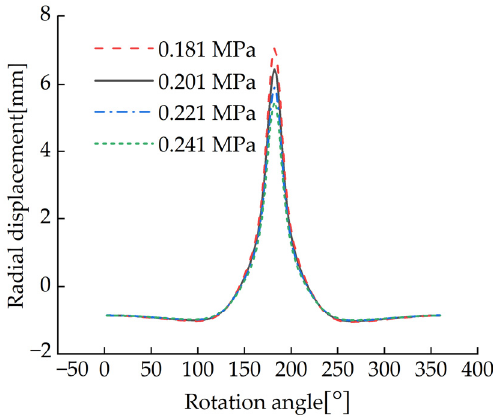
Figure 11. Contact pressure distribution of tire longitudinal contact patch under different inflation pressures.